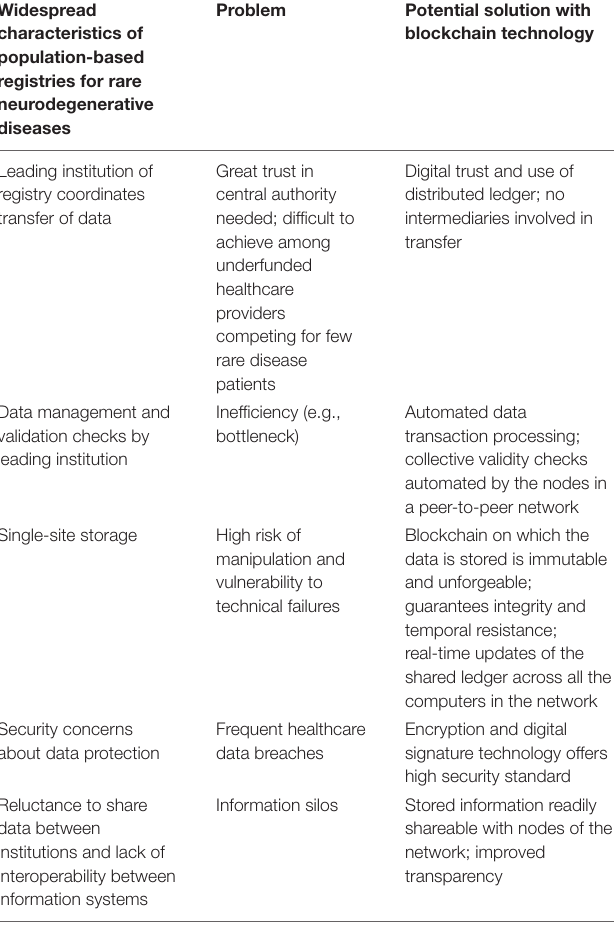
TABLE 1 | Potential innovative solutions for commonly encountered registry challenges using blockchain